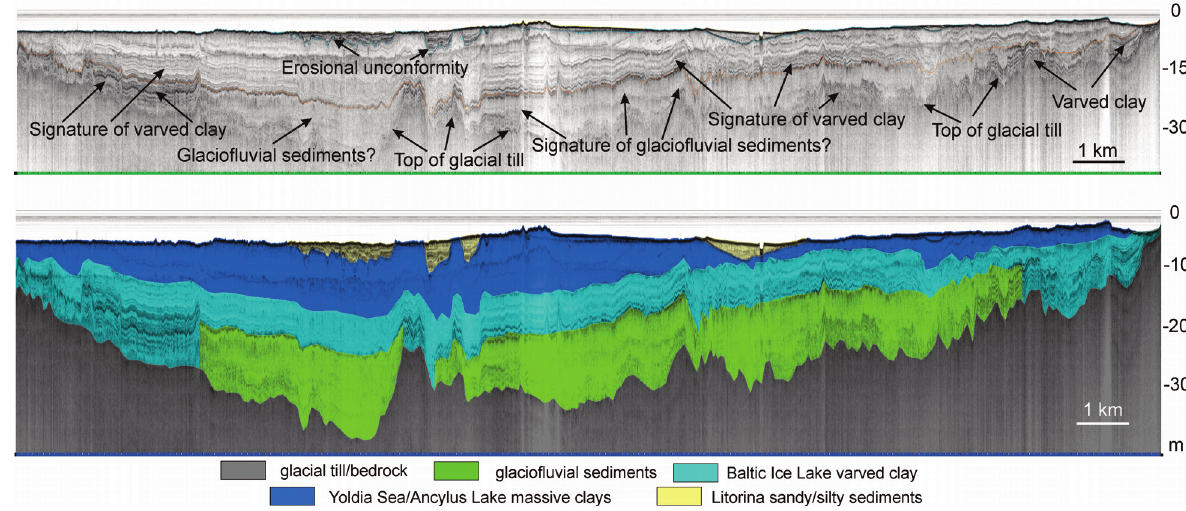
Fig. 8. High-frequency chirp recording NW of Kesselaid (for the location, see profile 1 in Fig. 1B) shows varying/mixed seismo- acoustic signatures in the layer overlying the till. Signature of massive or weakly layered sediments (outwash of the glaciofluvial sediments?) is occasionally mixed/replaced and covered with the fine-layered sections/patches (Baltic Ice Lake varved